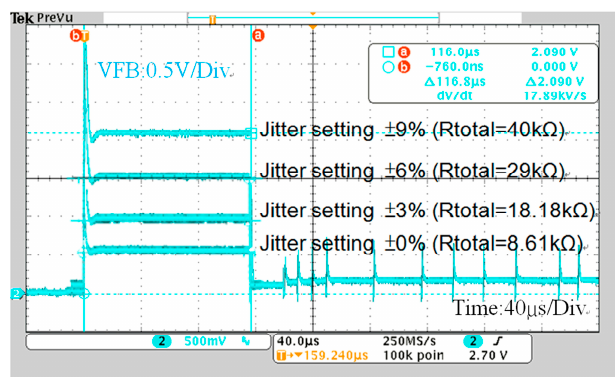
Figure 18. Using the feedback (FB) pin to set frequency swapping range.